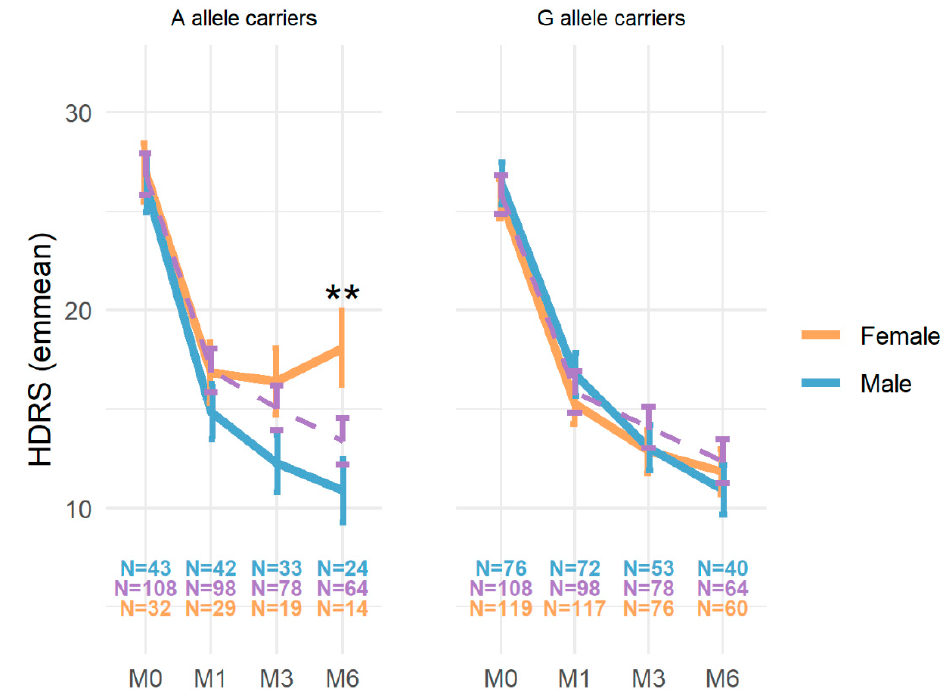
Figure 1. HDRS scores according to sex and MAOA rs979605 genotypes. Model estimates of the HDRS score (y-axis) at different study time points (x-axis) for MAOA rs979605 A allele female homozygotes (orange), female heterozygotes (purple dashed), and male carriers (blue). G allele carriers (right) are shown for comparison only. ** p < 0.01 following Bonferroni correction for the nine comparisons in A allele carriers. HDRS, 17-item Hamilton Depression Rating Scale.